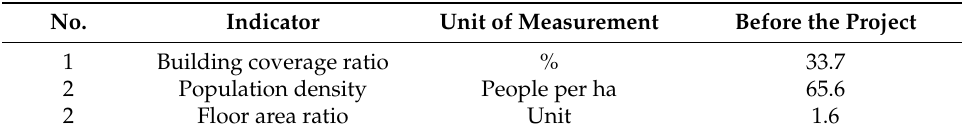
Table 3. Land e ffi ciency of the monocentric concept.